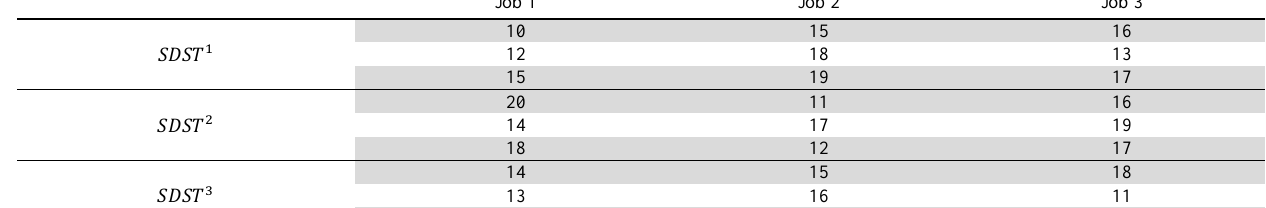
Sequence dependent setup times of the example